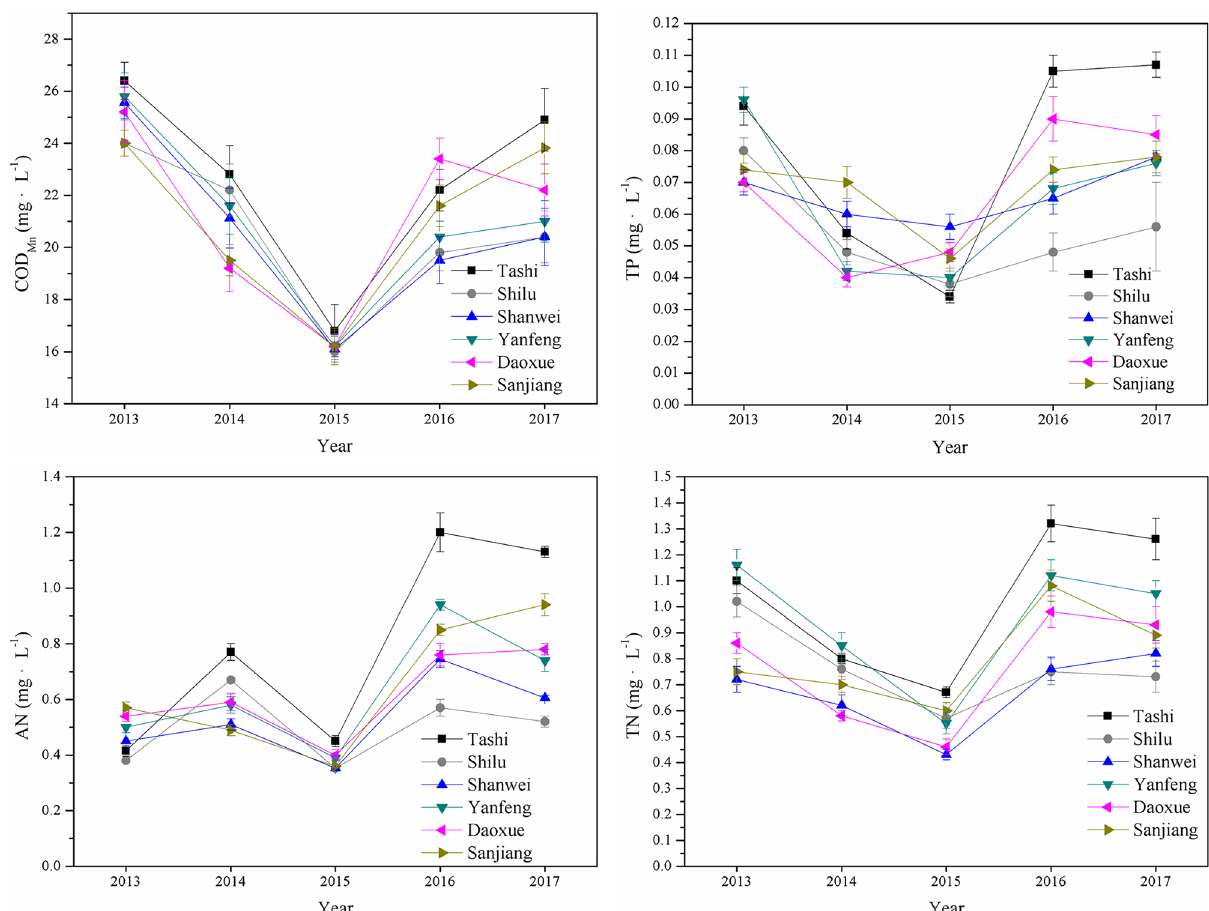
ard deviation during different years; the bars represent the stand- , TP, TN and AN in Mn ard deviations of values from different stations in the study area of each